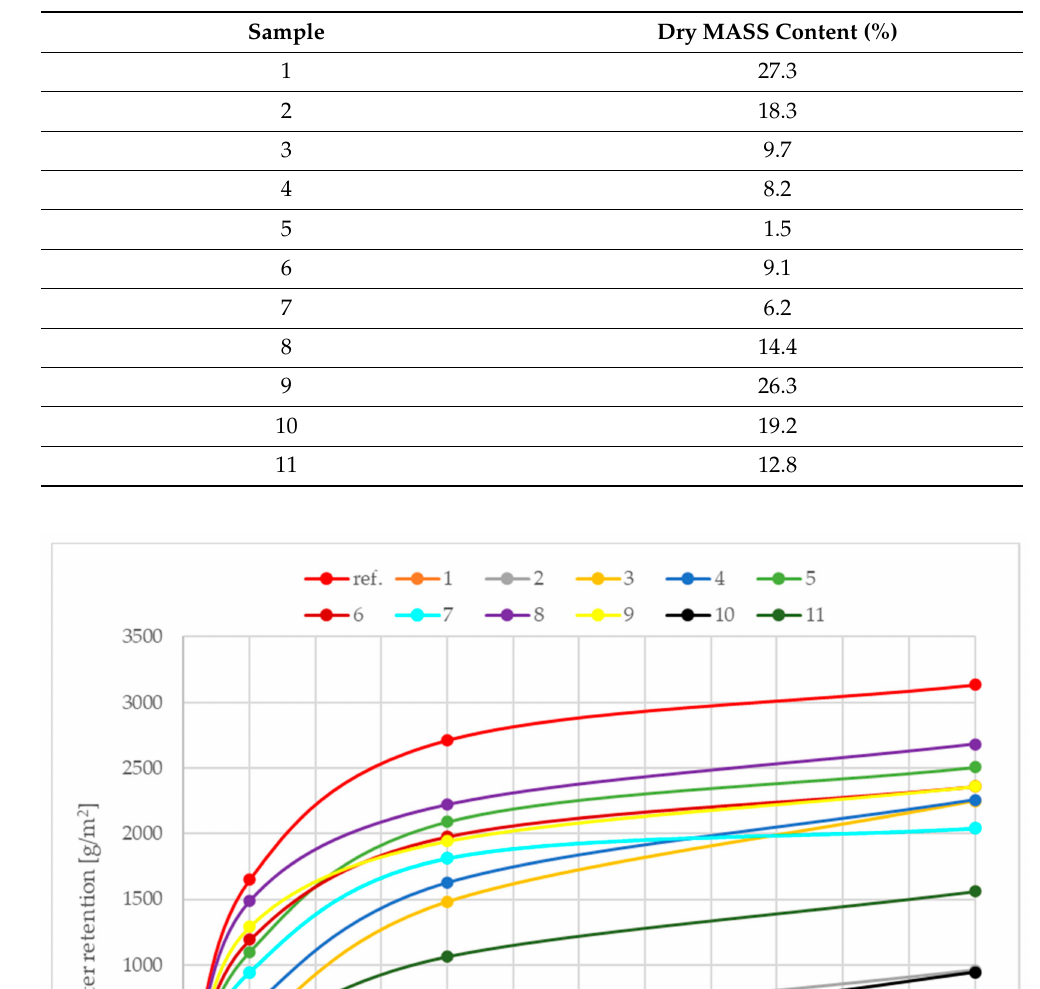
Table 2. Dry mass content in tested products.